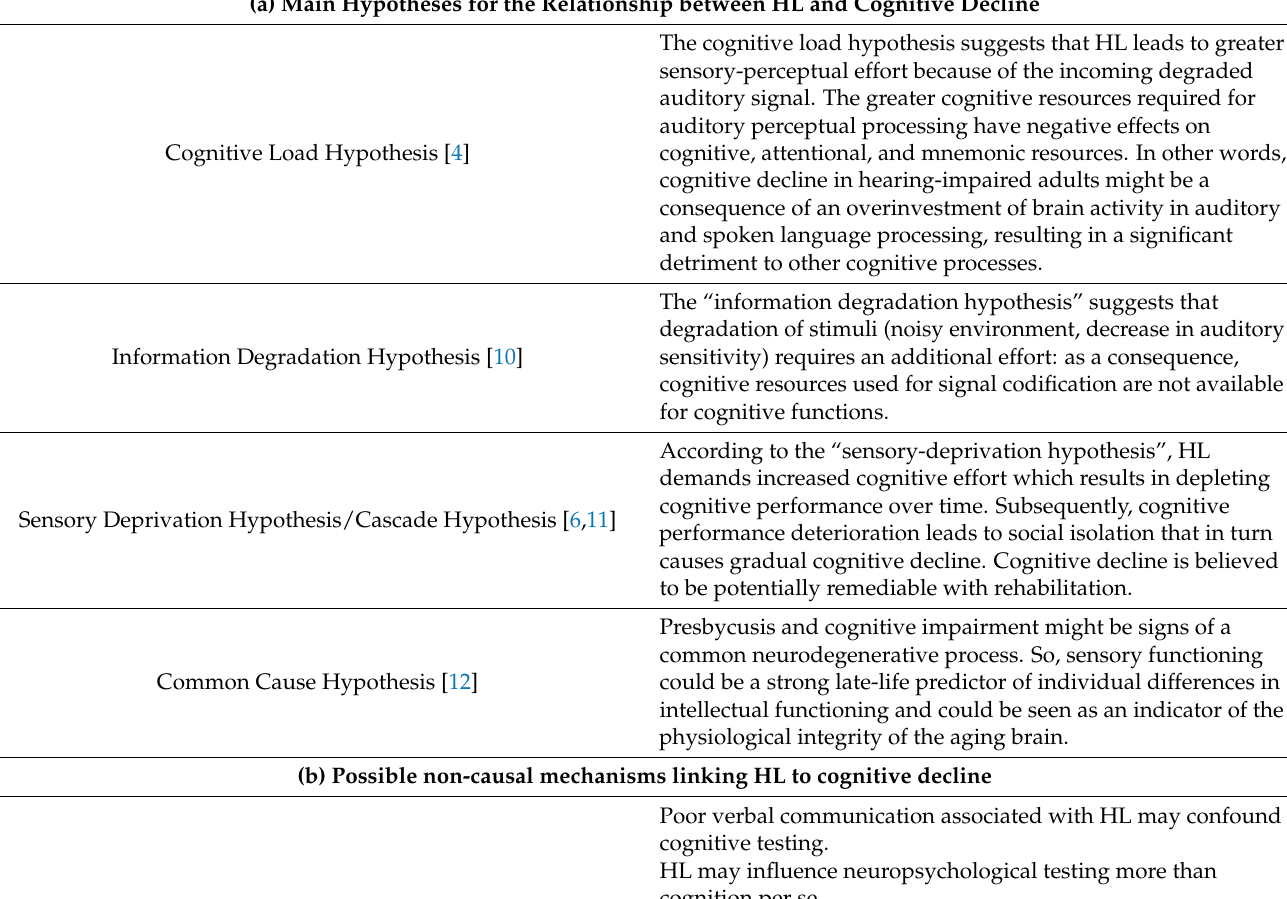
Table 1. Causal and non-causal mechanisms linking HL and Cognitive